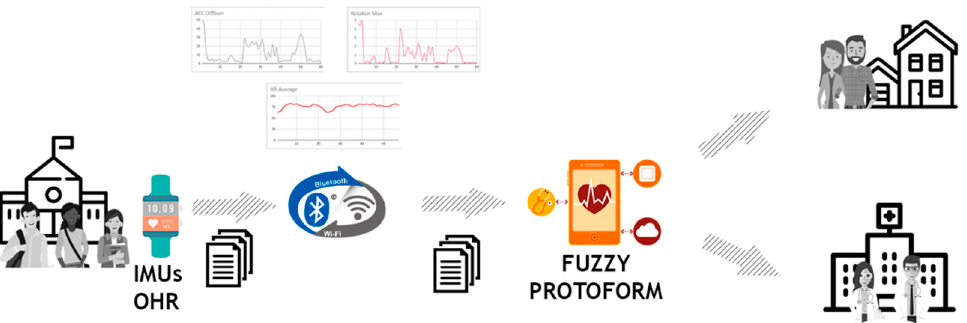
Figure 1. System architecture with a wearable device and a mobile device.